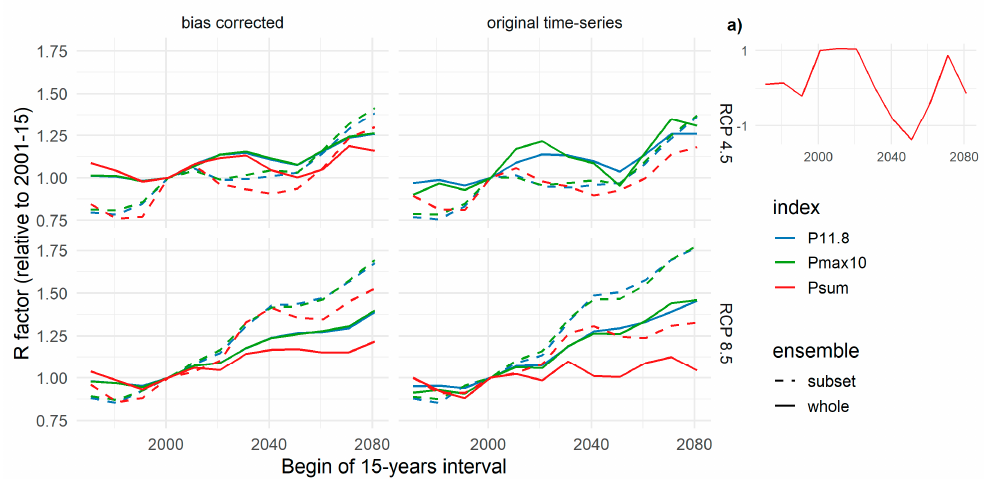
Figure 6. Variability of average R factors estimated with Equations (1)–(3), and the climate models, separated by bias correction (columns), RCP (rows), ensemble (line style), and rainfall index (color). ( a ) Changes were partly negative when Equation (1) (P sum ) was applied to the uncorrected model ensemble for RCP 4.5.